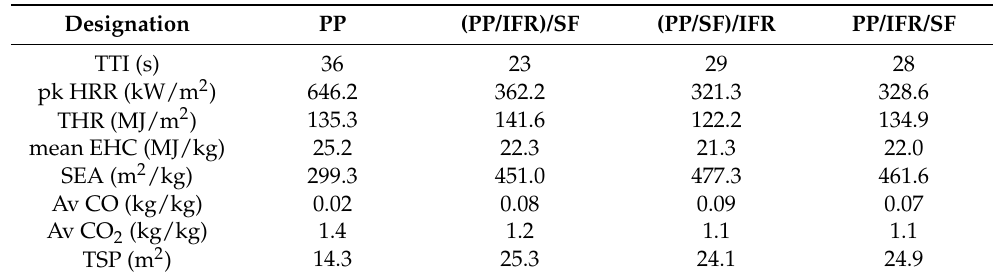
Cone calorimetric combustion experimental results of pure PP and PP/SF flame- retardant composites.